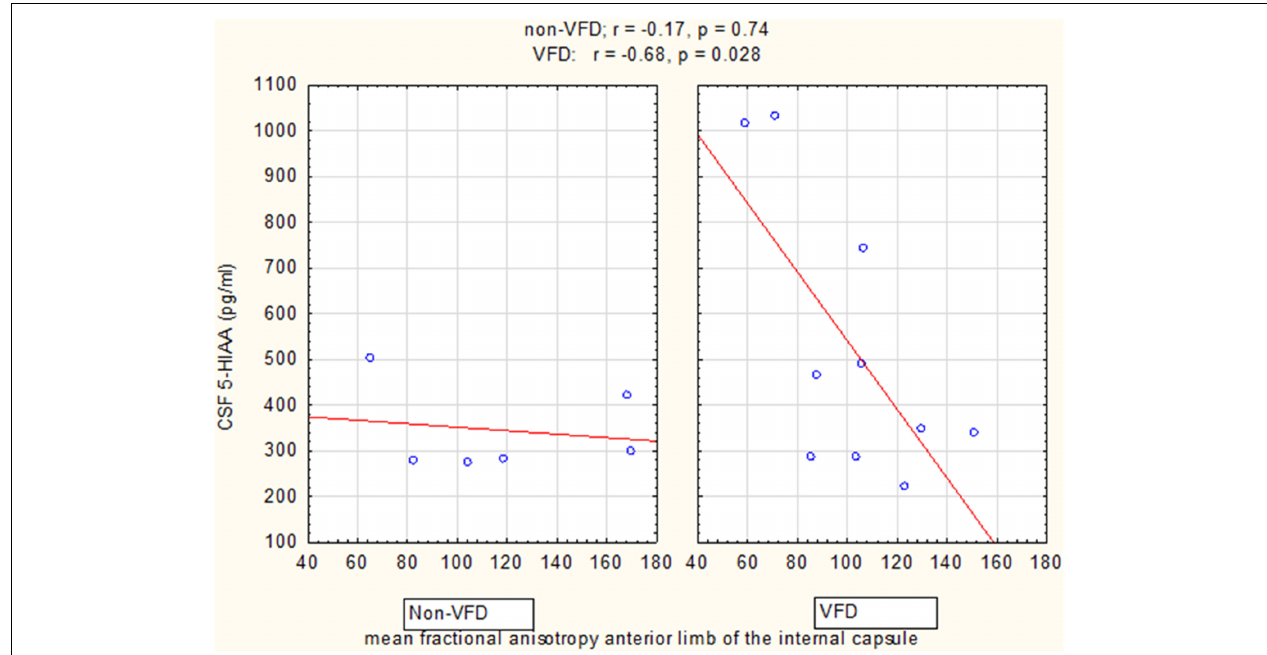
FIGURE 5 | Relationship of cisternal CSF 5-HIAA concentrations to mean fractional anisotropy of the anterior limb of the internal capsule. For mean fractional anisotropy (FA) of the anterior limb of the internal capsule